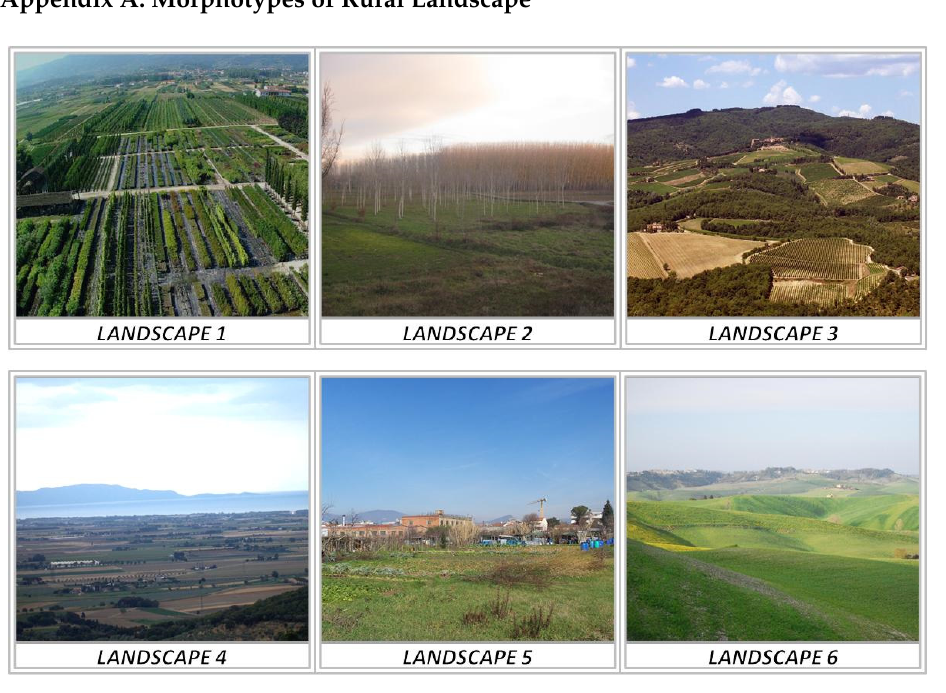
Figure A1 List of Considered Morphotypes Figure A1. List of Considered